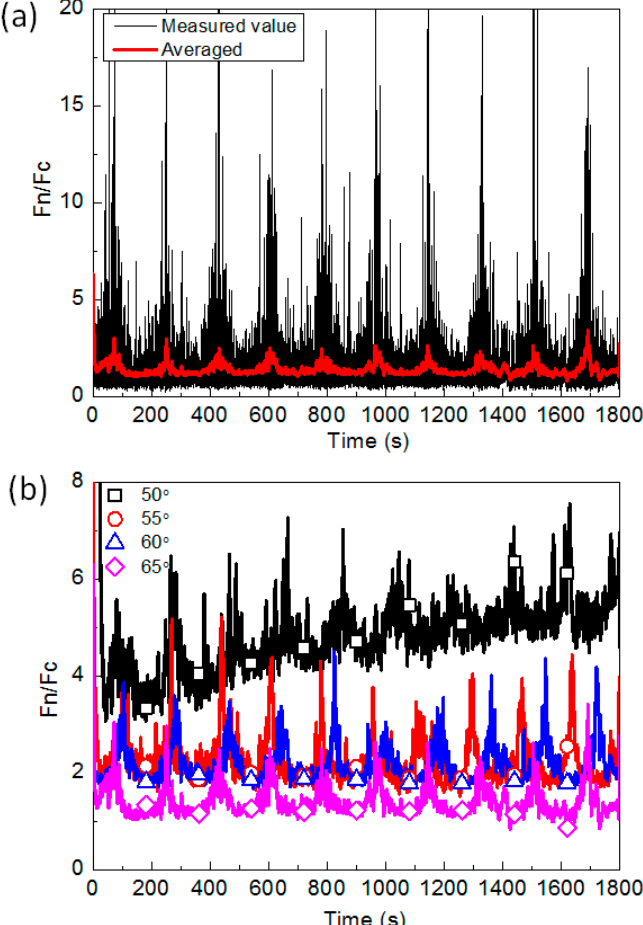
Figure 4. Variation of F n / F c with time. ( a ) Original data and treated data after averaging (at back rake angle of 65°), ( b ) at different back rake angle.